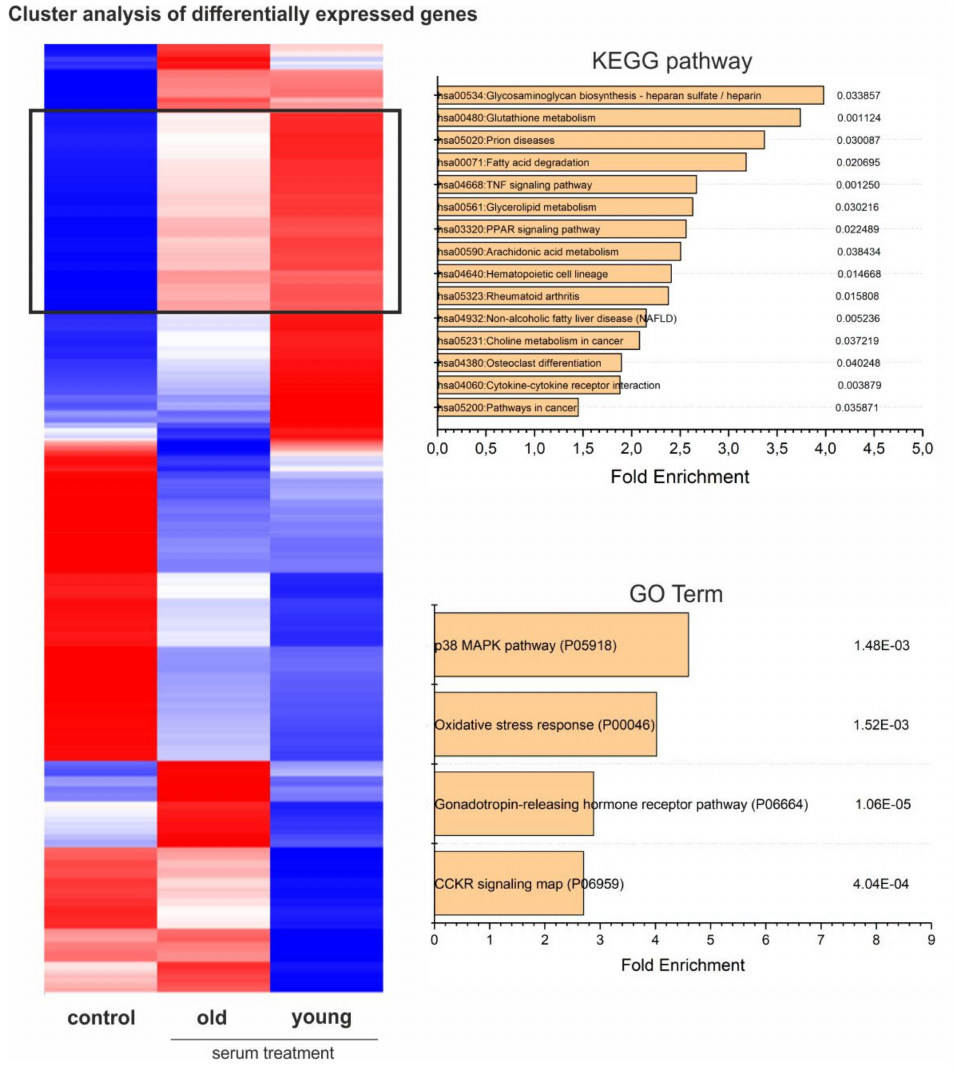
Figure 6. Heatmap of di ff erentially expressed genes with KEGG-pathway analysis and GO-term enrichment of genes highly upregulated in hCSCs treated with young serum, slightly upregulated in hCSCs treated with old serum and downregulated in the control (cluster marked with black box). 3.11. Beneficial E ff ects of Blood Plasma on Proliferation and Protection of hCSCs Against Senescence